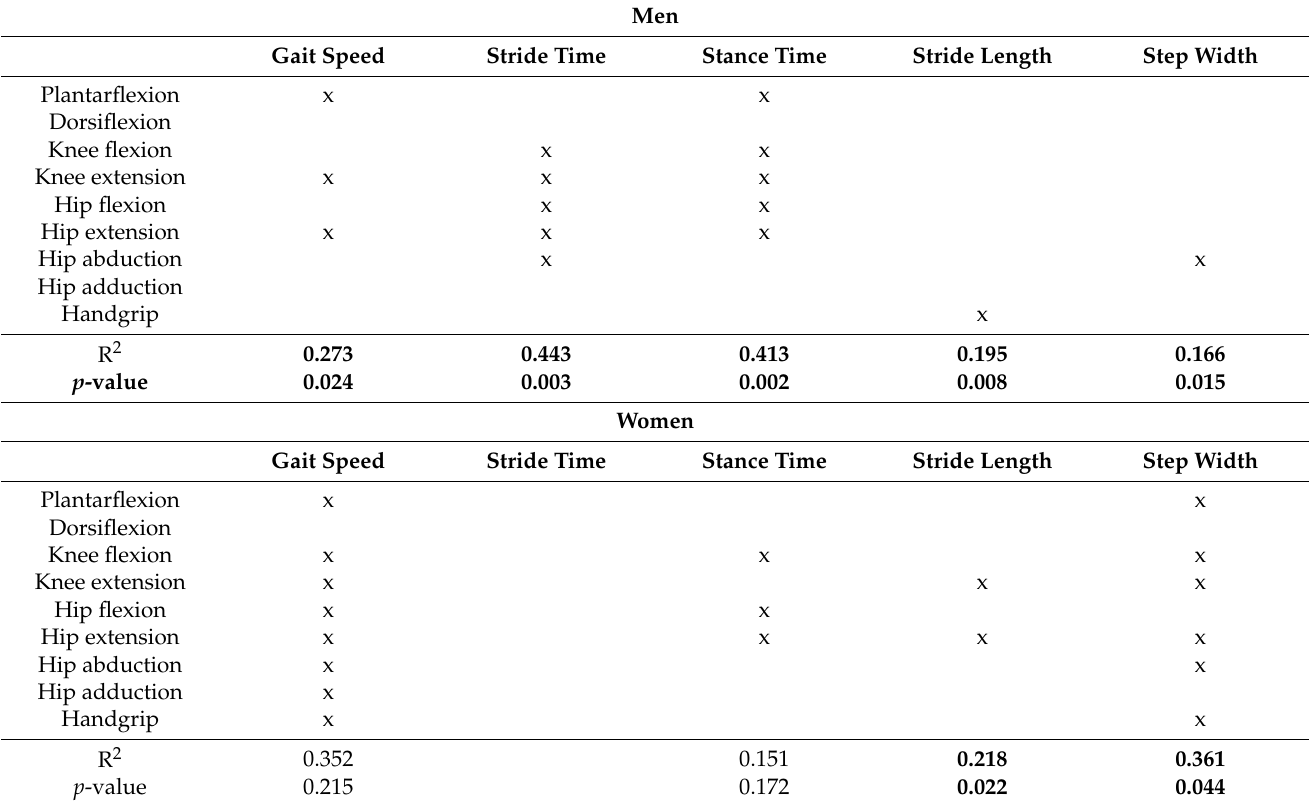
Table 4. Regression analysis between independent muscle group strength (predictors) and gait parameters (dependent variable). “x” marks included muscle